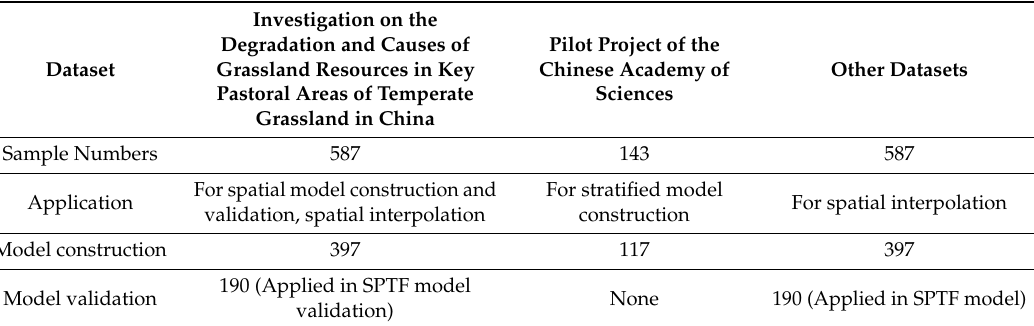
Table 1. Di ff erent datasets source and